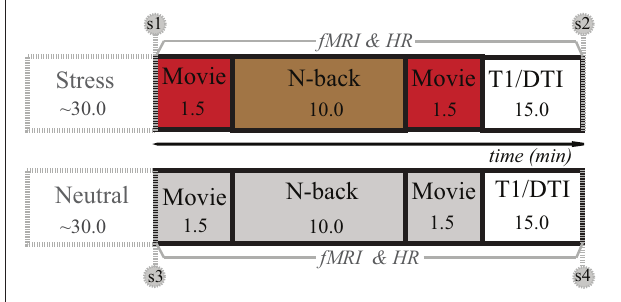
FIGURE 1 | Overview of experimental design. The experiment consisted of stress and control conditions (or sessions), and the order was counterbalanced across participants. After preparation outside the scanner, a numeric N-back WM task was administered twice: in one session it was embedded in a stressful context and the other one in a neutral control condition (see Stress induction for details). Note: The numbers in the squares indicate the time in minutes. S1–S4 represents four saliva samples coinciding with subjective mood ratings (PANAS). T1 and DTI stand for a high-resolution anatomical scan and a diffusion tensor imaging